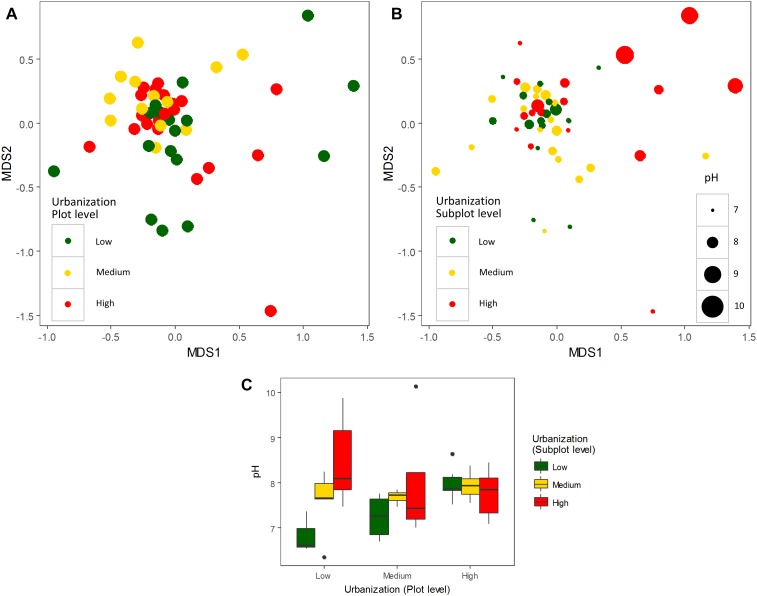
Non-metric multidimensional scaling (NMDS) plot of bacterioplankton communities (abundant OTUs – relative abundance ≥ 0.1%) colored by urbanization categories (low, medium, and high) at plot level (A) and subplot level (B). Urbanization categories are represented by colors and pH values represented by the size of each dot for the subplot level. (C) Box-plots of pH values across urbanization categories (low, medium, and high) at subplot and plot levels.